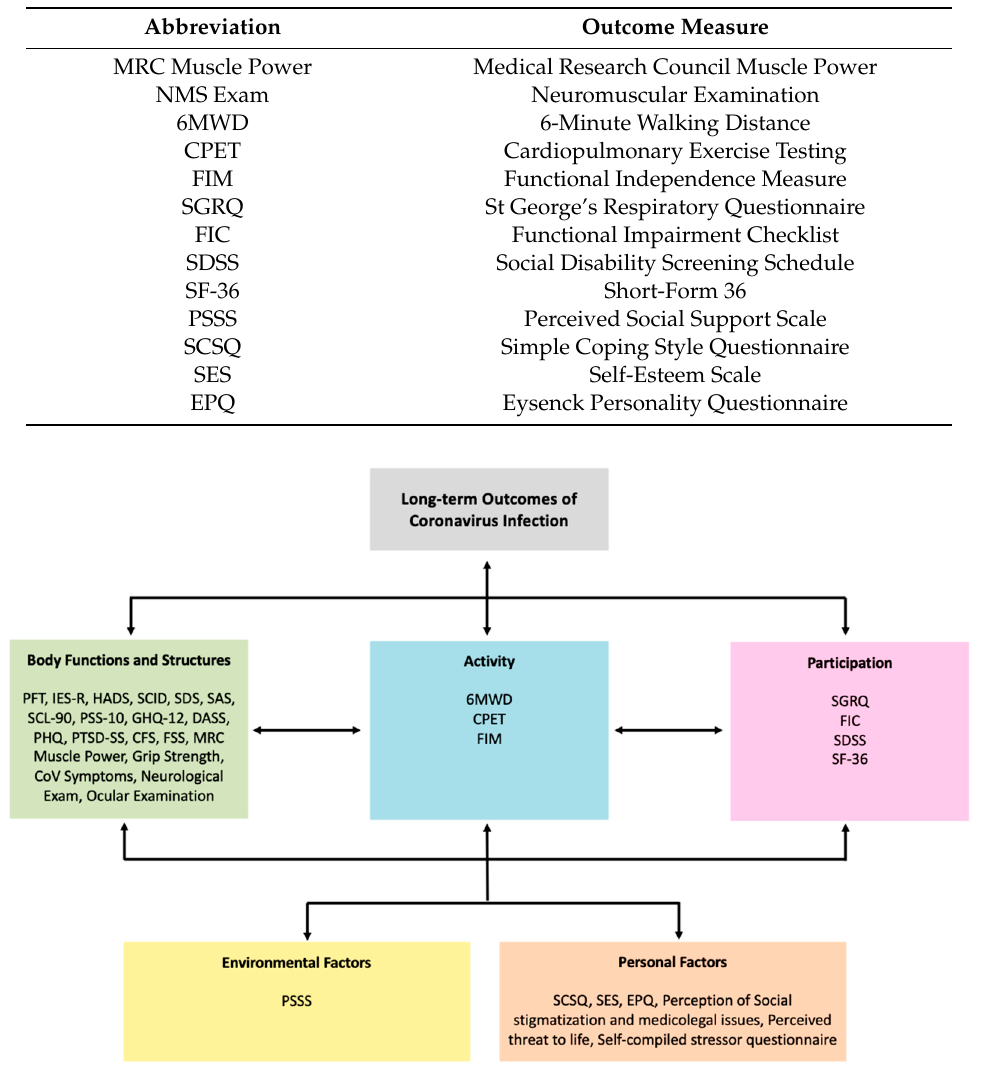
Figure 2. International Classification of Functioning, Disability and Health (ICF) categorization of outcome measures used in long-term follow-up studies of coronavirus survivors.